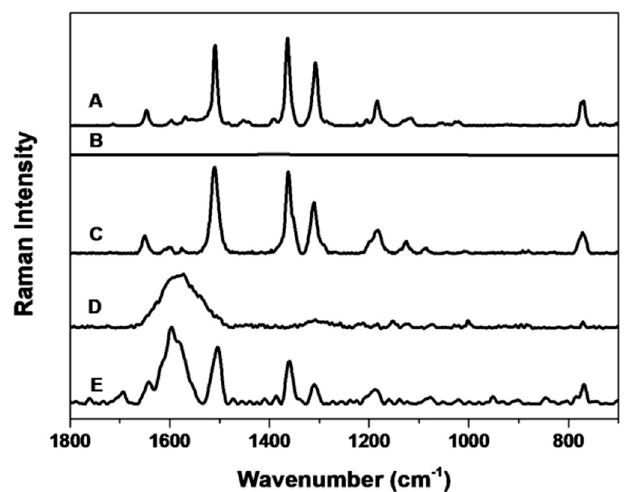
Figure 4. Raman and SERS spectra from different steps in the nanosystem synthesis. Raman spectra of pure R6G solution ( A ) and R6G at the same concentration used in the AgNP@R6G@BSA